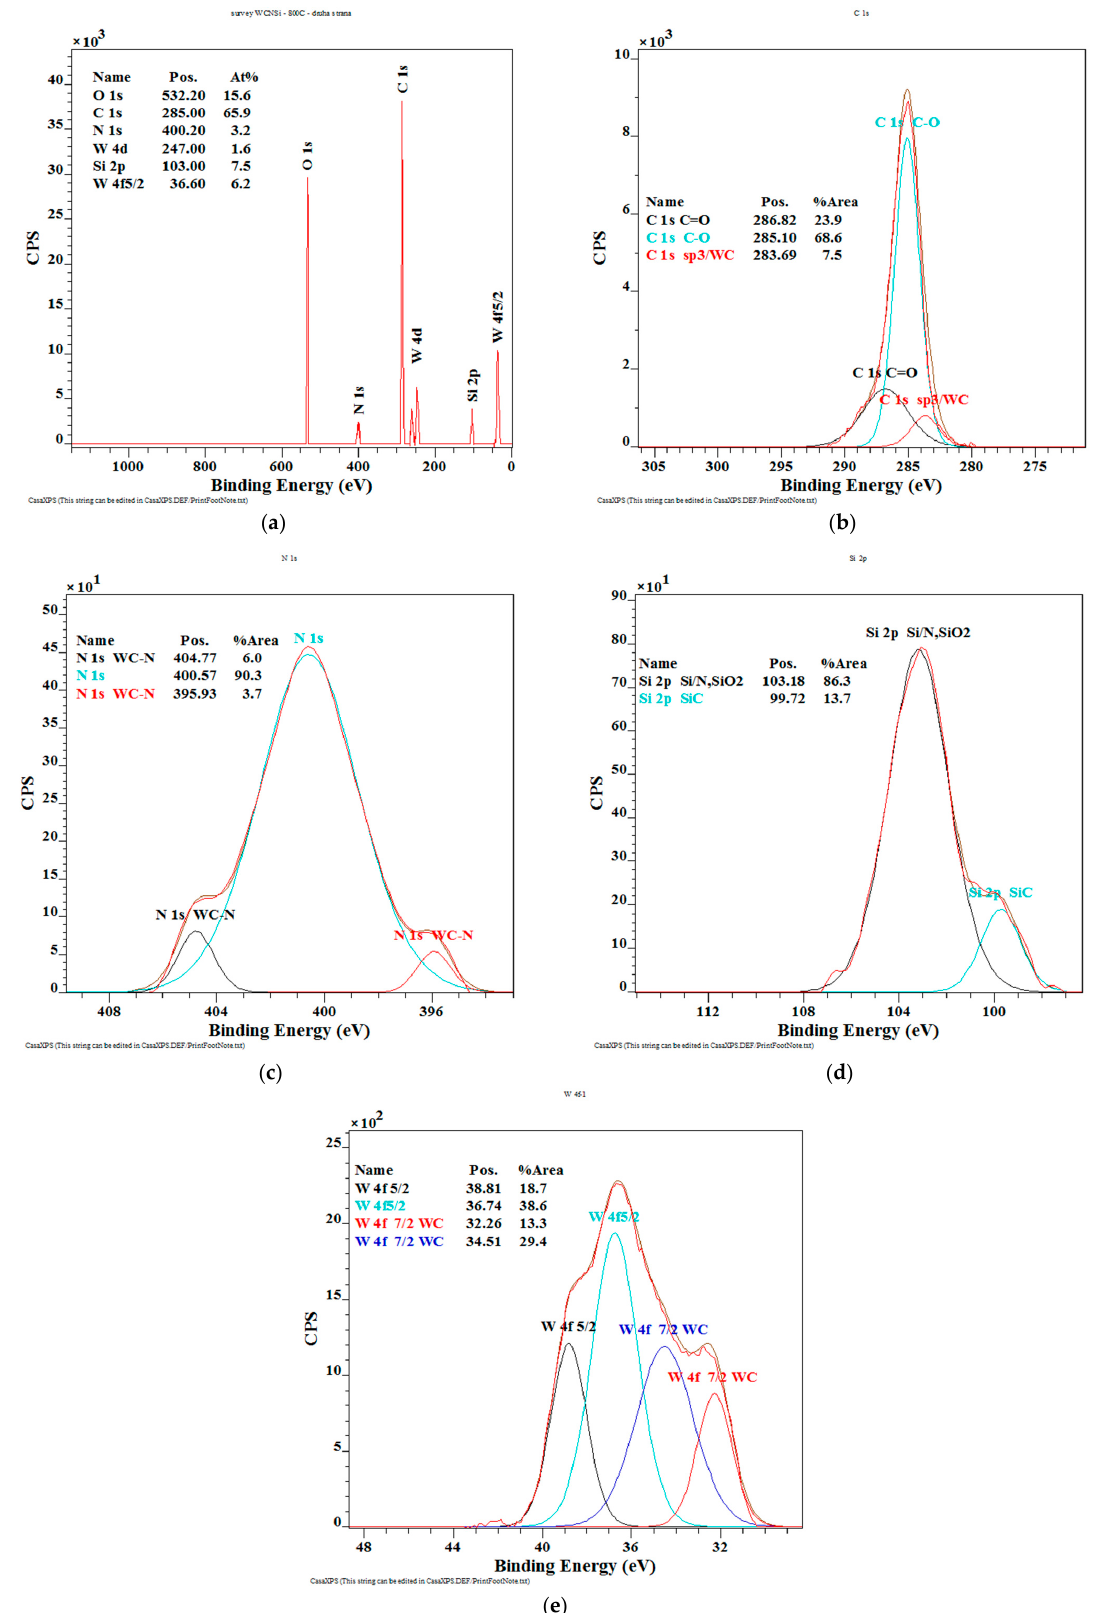
Figure 6. The XPS results from the surface of the WC/C annealed coating at 800 °C (at.%): ( a ) Chemical composition; ( b ) chemical bonds C; ( c ) chemical bonds N; ( d ) chemical bonds Si; ( e ) chemical bonds W.